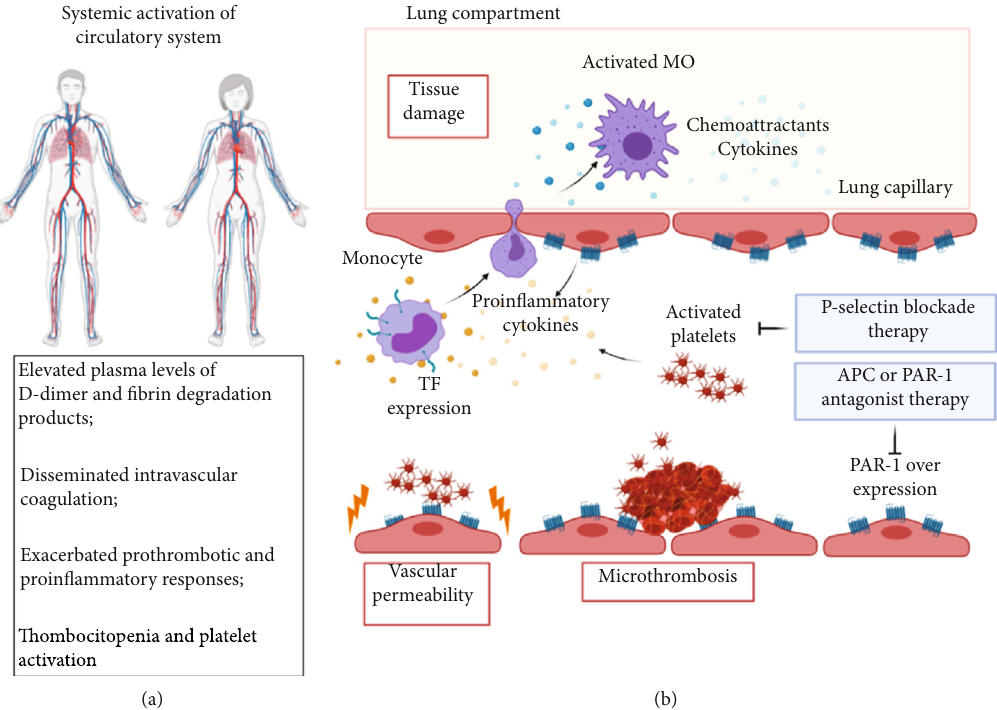
Figure 3: Hemostatic disorder in SARS-CoV-2 infection. (a) In COVID-19 cases, there occurs a systemic activation of the circulatory system as a re fl ection of what occurs in the lungs. (b) In the lung compartment, monocytes expressing TF perform an intense diapedesis under stimuli of proin fl ammatory and chemoattractant cytokines, in fi ltrating activated macrophages in the lung that lead to tissue damage. The high production of proin fl ammatory cytokines, as well as vascular permeability and microthrombosis events are prompt to overexpress PAR-1 receptors and abnormal platelet activation. Overexpression of PAR-1 can be blocked with APC or PAR-1 antagonist therapy, while abnormal platelet activation can be avoided by P-selectin blocker therapy. Created with